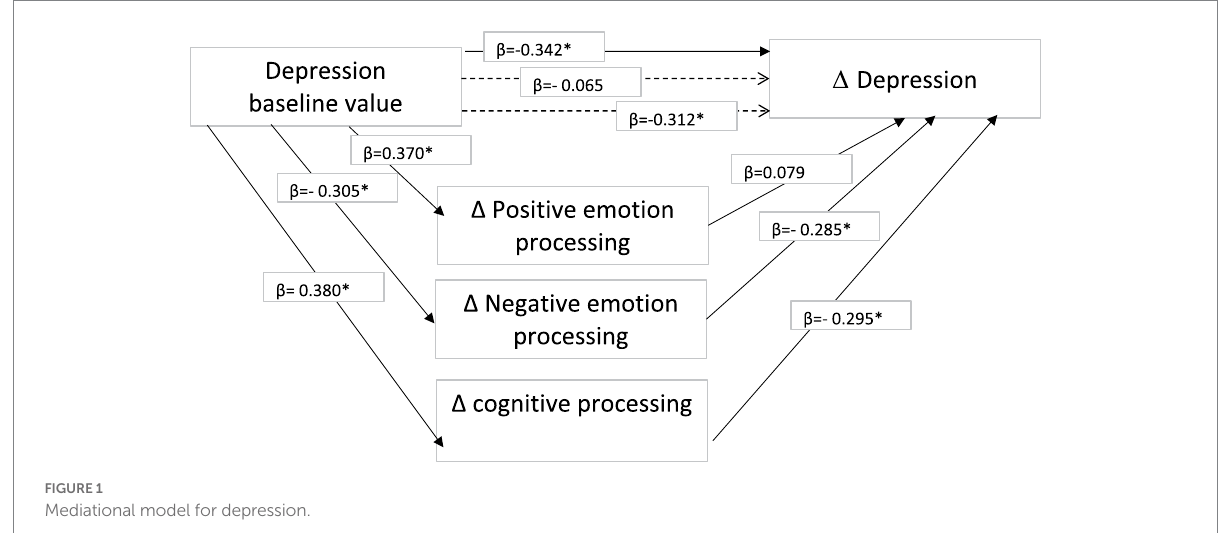
FIGURE 1 Mediational model for depression.